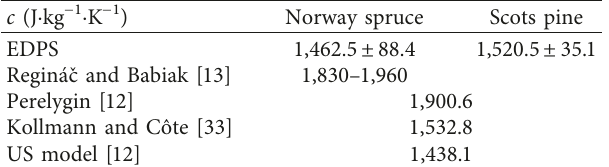
Table 5: Comparison of experimentally determined specific heat capacity and the specific heat capacity calculated using the models at the moisture content of